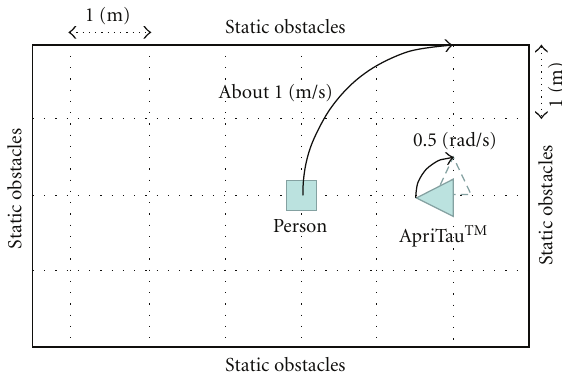
Figure 10: The experimental setting (Pattern 5). Table 3: The classification ratios in various patterns.